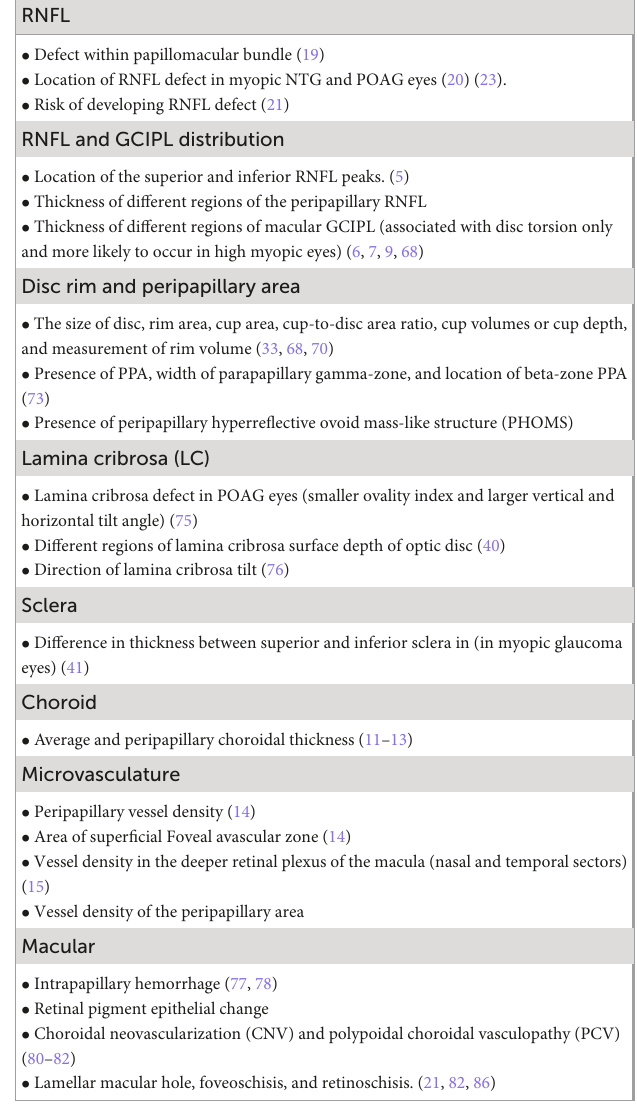
RNFL and GCIPL distribution